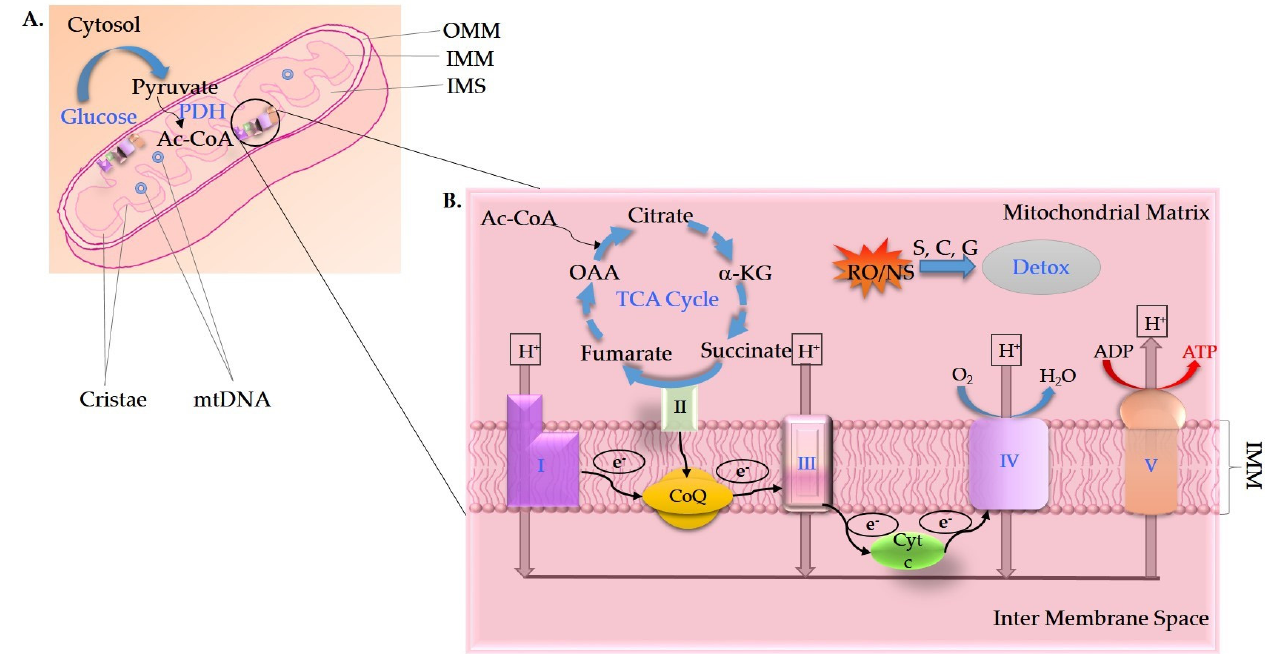
Figure 1. ( A ) Mitochondria are compartmentalized cellular organelles that contain an outer mitochondrial membrane (OMM), which is permeable to small molecules and proteins < 10 kD and contains porins (voltage-dependent anion channels (VDACs)), an inner mitochondrial membrane (IMM) that lacks nonspecific permeability, and an area between the OMM and IMM known as the intermembrane space (IMS). The inner membrane is highly folded into structures known as cristae, the site of ATP production. The space inside the IMM is filled with a gel-like mitochondrial matrix, which contains mitochondrial DNA (mtDNA), and enzymes of the tricarboxylic acid (TCA, also known as the citric acid or Krebs) cycle and fatty acid beta-oxidation, among others. ( B ) Glycolysis metabolizes glucose to pyruvate, which, after a series of reactions in the mitochondrial matrix, produces reducing equivalents nicotinamide adenine dinucleotide (NADH) and flavin adenine dinucleotide (FADH 2 ) in the TCA cycle. The NADH and FADH 2 are then re-oxidized in the electron transport chain (ETC). Mitochondrial cristae are the seat of mitochondrial oxidative phosphorylation (OXPHOS) machinery, namely ETC complexes I-IV, two electron carriers, and a specialized ATP-synthesizing enzyme called ATP synthase or complex V. The energy released by the transfer of electrons through ETC complexes is utilized to transport protons across the IMM into the IMS. The flux of protons back into the mitochondrial matrix is mostly mediated by ATP synthase, which harnesses the energy to generate ATP from ADP. Reactive oxygen/nitrogen species (RO/NS) are produced during this process, which are detoxified/countered (Detox) by antioxidant enzymes such as superoxide dismutase (S), catalase (C), and glutathione peroxidase (G), etc. Processes/molecules affected in AD are shown in bright blue